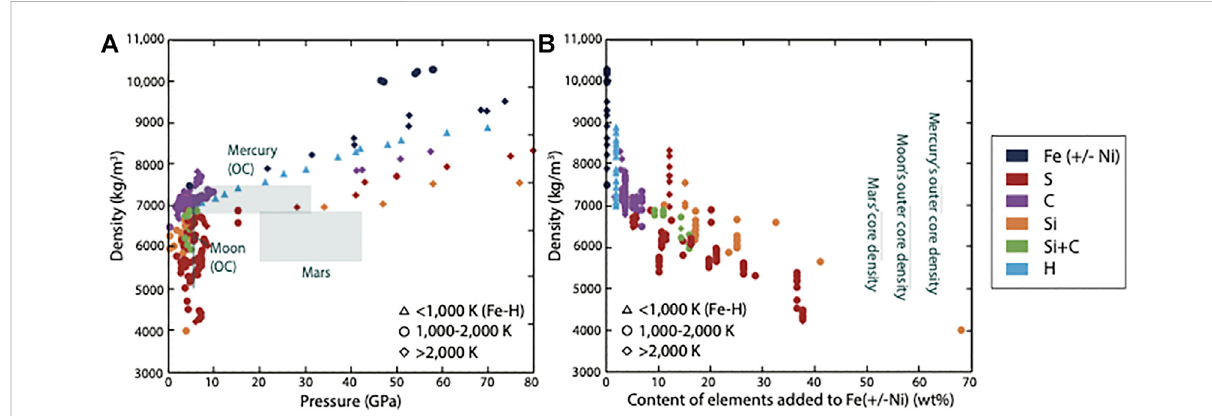
FIGURE 3 Density of liquid iron and iron alloys from previous experimental studies as a function of pressure (A) , and content of elements added to Fe or Fe+Ni (B) for different temperatures. The core conditions of Mars (5,700 – 6,900 kg/m 3 ), the Moon (5,000 – 7,000 kg/m 3 ), and Mercury are indicated with shaded areas, and values depending on the studies considered (see text for details). Data source: Chen et al., 2014; Knibbe et al., 2021; Kuwayama et al., 2020; Lee et al., 2015; Mao et al., 2004 (solid); Morard et al., 2013, 2014, 2017; Nishida et al., 2008, 2011; Sanloup et al., 2000, 2004,2011;Shibazakietal.,2012(solid);Shimoyamaetal.,2013,2016;Tateyamaetal.,2011;Terasakietal.,2010,2019;Urakawaetal.,2018;Xuetal., 2021; Zhu et al., 2021.